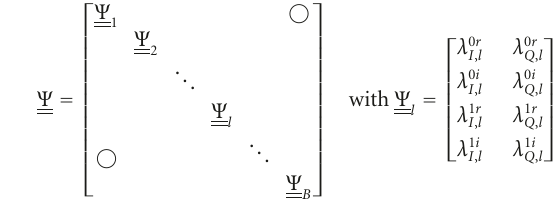
Figure 7: Block diagonal